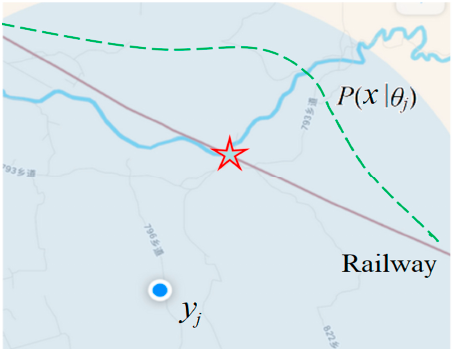
Figure 4. Illustrating a GPS device’s positioning with a deviation. The round point is the pointed position, the star is the most possible position, and the dashed line is the predicted probability distribution. Source: author.